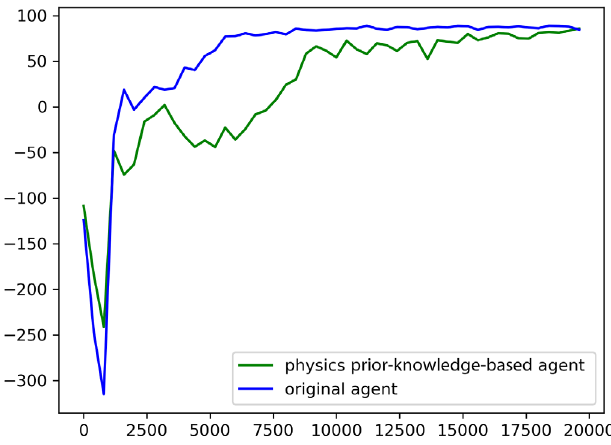
FIG. 5. The smoothed reward curves during the